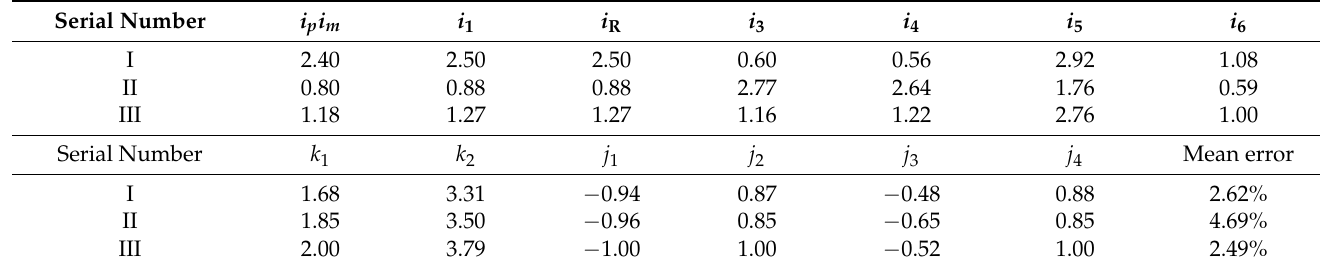
Table 2. Comparison of multiple optimization